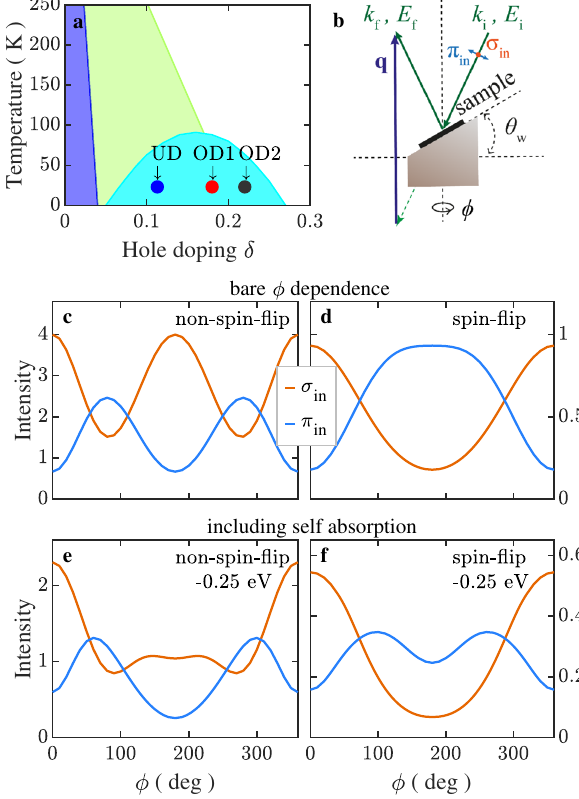
Fig. 1 Experimental setup and the azimuthal dependence of non- spin- fl ip and spin- fl ip RIXS responses. a Schematic temperature- doping phase diagram for Bi2212. The purple, green and cyan areas represent the antiferromagnetic, pseudogap, and superconducting states, respectively. The solid circles indicate the locations of the three measured samples (UD, OD1, OD2) in the phase diagram. b The scattering geometry of the azimuthal-dependent RIXS experiment on a wedged sample. c – f The azimuthal ϕ dependence of the non-spin- fl ip and spin- fl ip RIXS responses in cuprates with a 40 ∘ wedge angle ( θ w ). c , d are the `bare' ϕ dependence on in fi nite thin samples, while e and f give the intensity evolution on bulk samples including the self-absorption effect at an energy loss of − 0.25